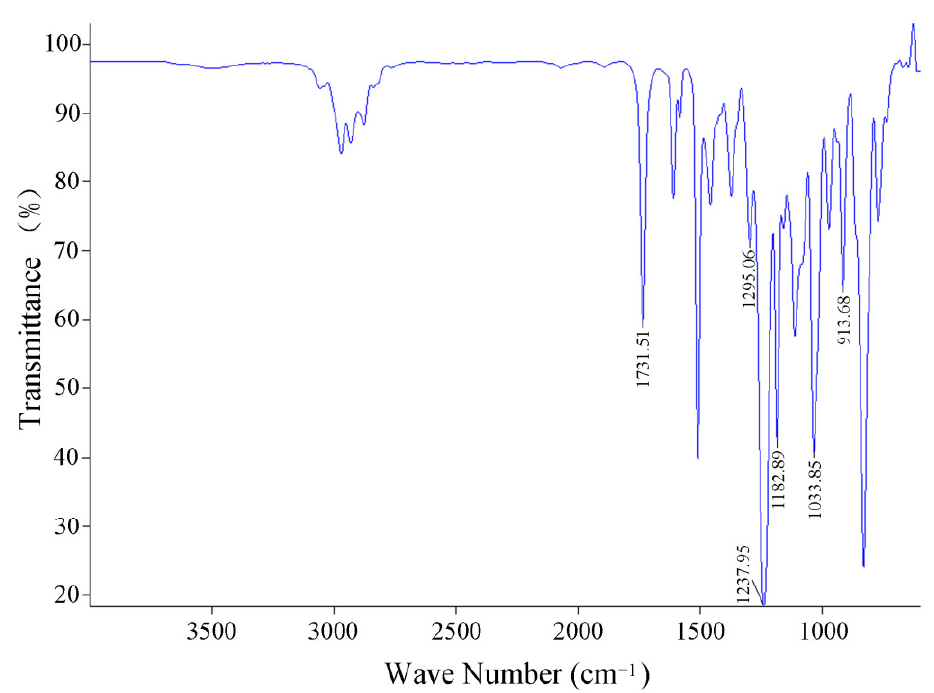
Figure 2. Infrared spectrum of fluorine modified epoxy resin.